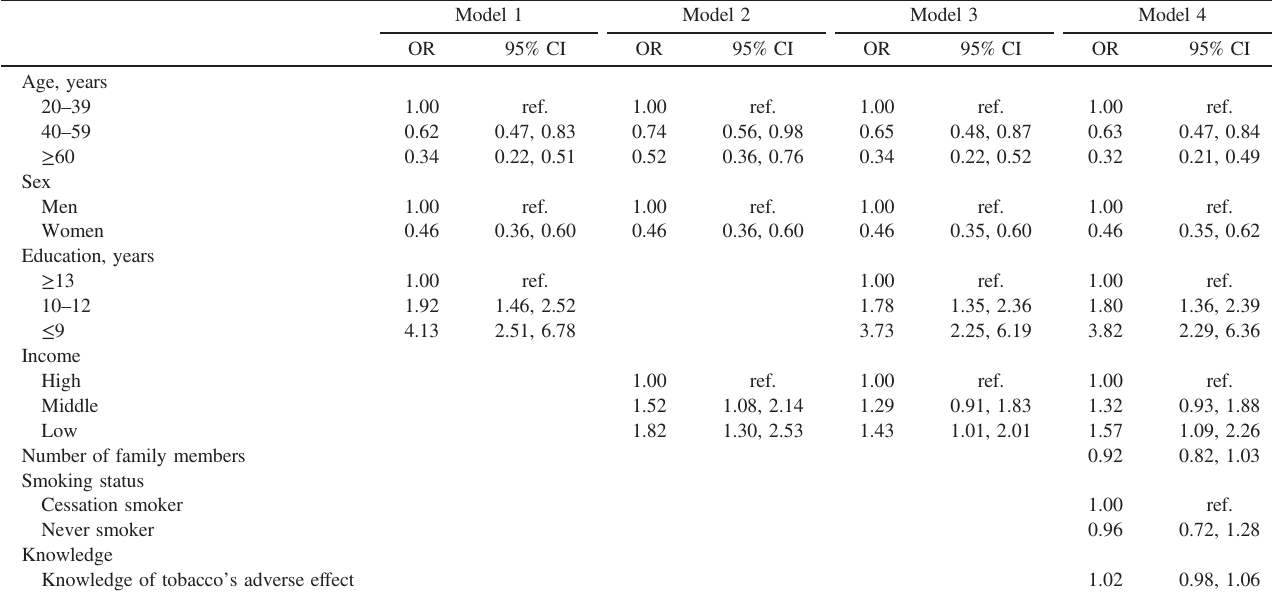
Table 4. Odds ratios for secondhand smoke at the workplace / school ( n = 1,003); multiple imputation was